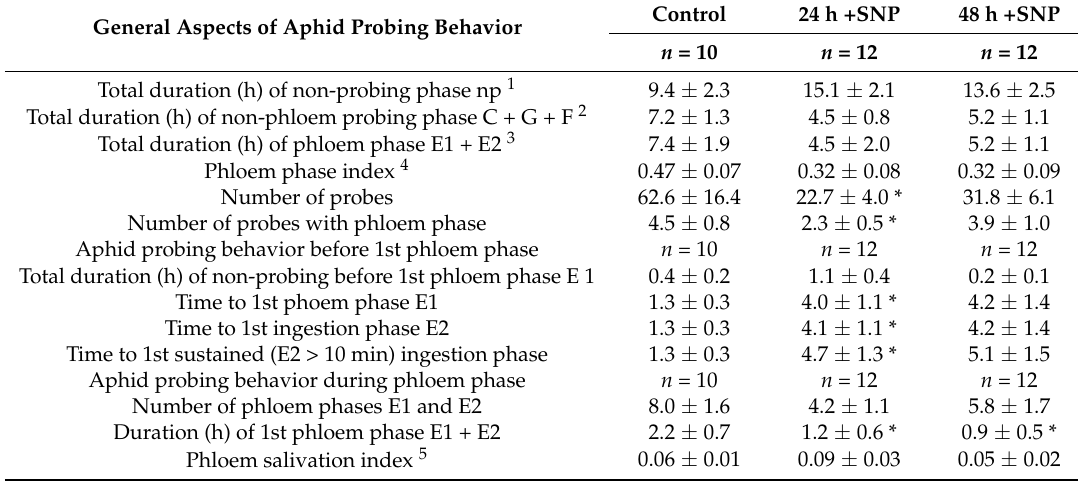
Table 4. Mean (± SE) non-sequential and sequential electrical penetration graph (EPG) parameters describing the probing behavior of Acyrthosiphon pisum on Pisum sativum treated with SNP. Control 24 h +SNP 48 h +SNP General Aspects of Aphid Probing Behavior n = 10 n = 12 n = 12 Total duration (h) of non-probing phase np 1 9.4 ± 2.3 Total duration (h) of non-phloem probing phase C + G + F